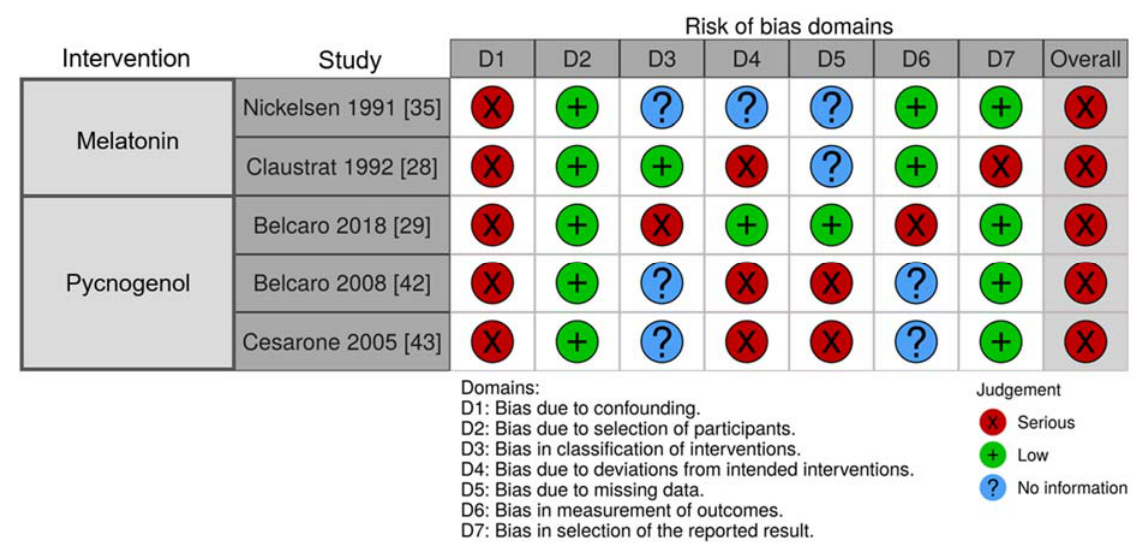
Figure 6. Risk of bias of randomized controlled trials assessed using the Cochrane’s Robins I Tool presented according to intervention agent as indicated [24,28,34,35,37].